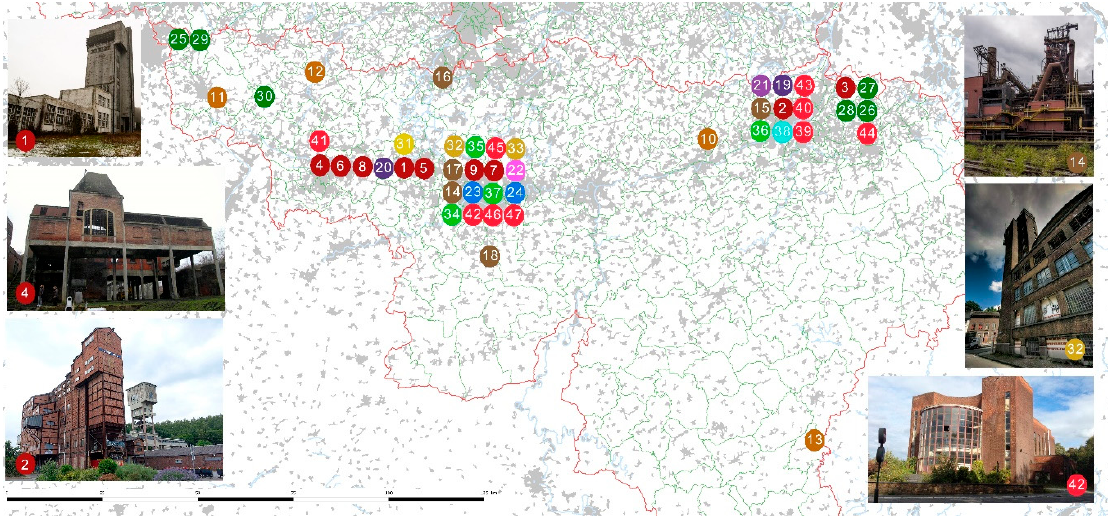
Figure 6. Industrial heritage in Wallonia counting